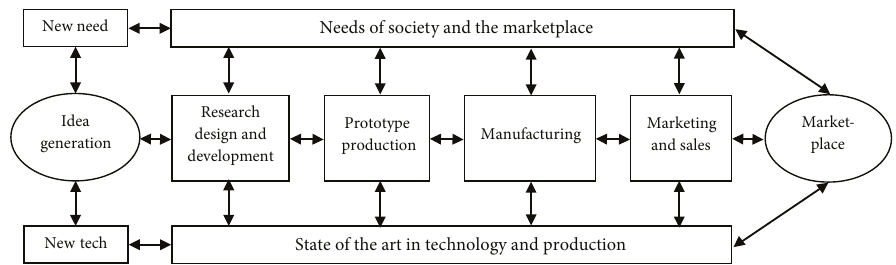
Fig. 1. Innovation process in corporate (Rothwell